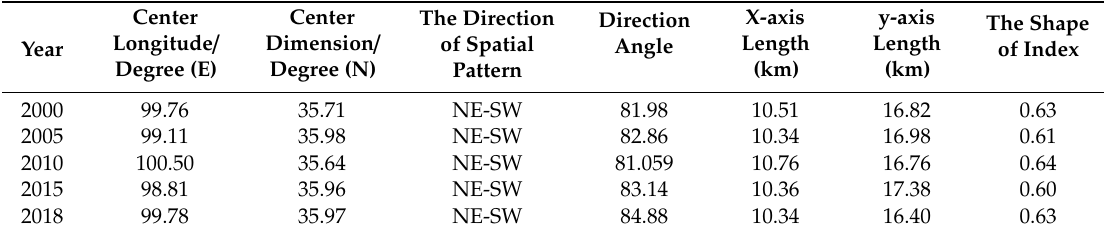
Table 3. Standard deviation ellipse parameters of annual average vegetation coverage in west